Question: Draft a figure caption describing what is shown.
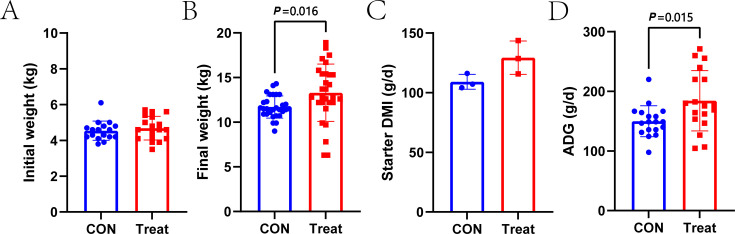
Answer: Effects of supplemental fermented Chinese herbal medicine on the growth performance of lambs. Data are presented as mean ± SEM. Group comparisons were analyzed using an independent samples t -test. Bar graphs comparing growth metrics in lambs with fermented Chinese herbal medicine supplementation. ( A ) Initial weight; ( B ) final weight; ( C ) starter DMI; ( D ) ADG. Treatment group shows significantly higher final weight ( P = 0.016), dry matter intake, and average daily gain ( P = 0.015) despite similar initial weights.